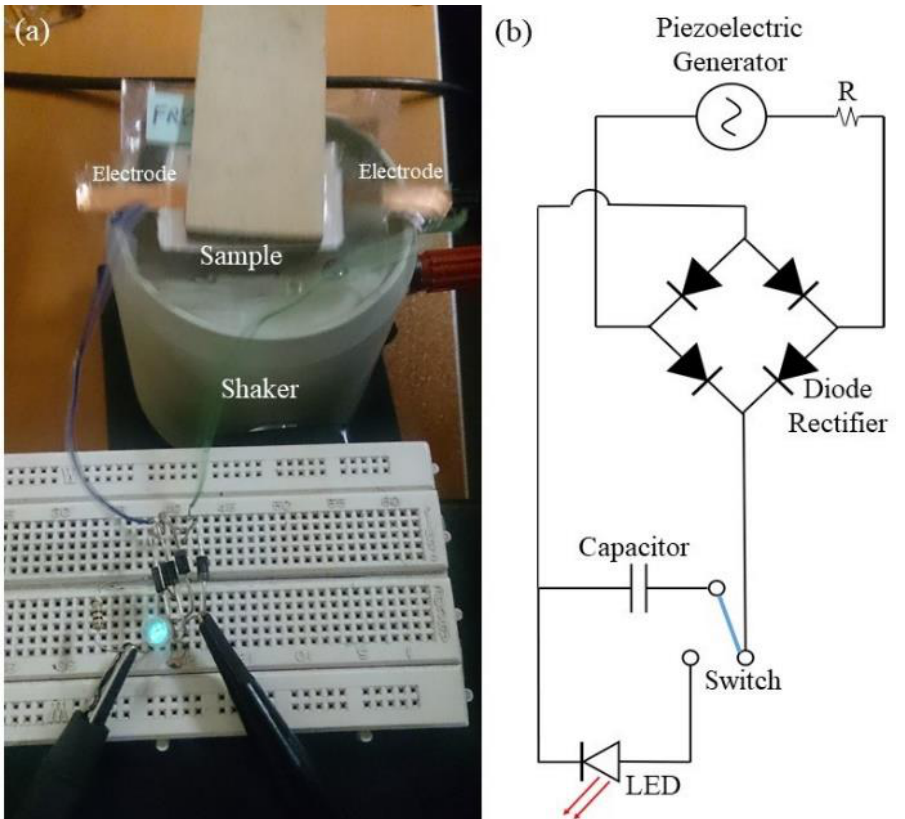
Figure 6. ( a ) A snapshot of flashing LEDs during excitation by shaker at 200 Hz, ( b ) schematic diagram of the prototype energy-harvesting circuit.